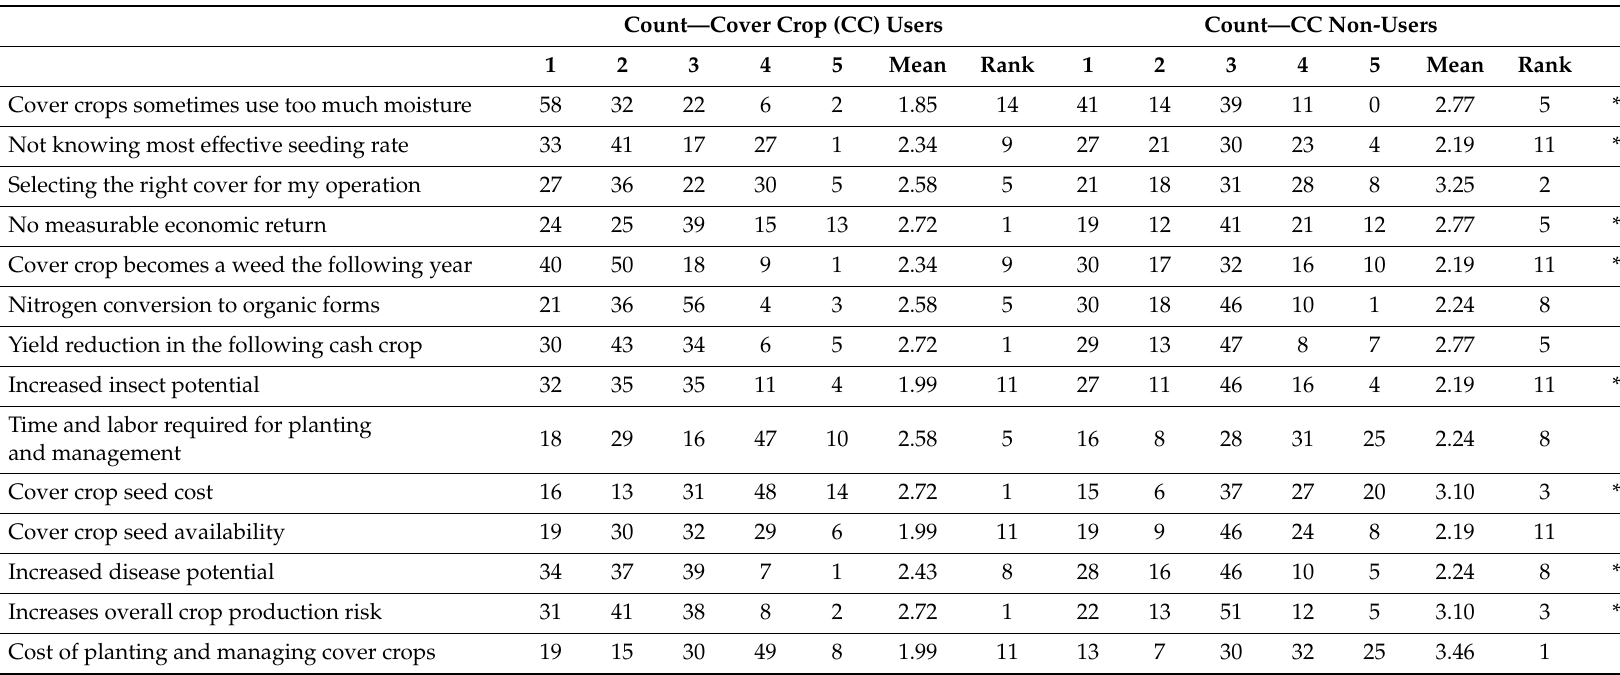
Table 1. Selected challenges associated with planting cover crops; means compared between cover crop users and non-users. Count—Cover Crop (CC)